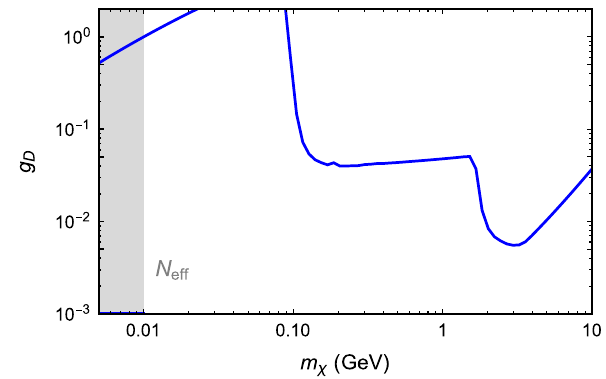
= Fig. 1 The coupling parameter g as a function of m χ with m φ D L 3 m χ adopted. The value of g is derived by demanding that the relic D density of χ ¯ χ is equal to today’s DM observation value (cid:14) D h 2 = 0 . 120 [48],withtwomodesof χ ¯ χ annihilatinginto (cid:9) ¯ (cid:9) and γγ considered.The shaded region is the possible bounds on DM masses from the effective number of relativistic neutrinos N eff [33,34]